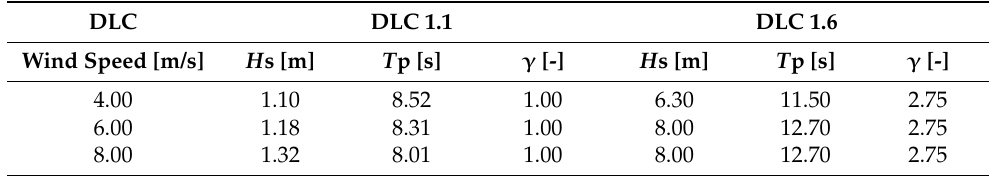
Table 3. IEC design load case matrix.